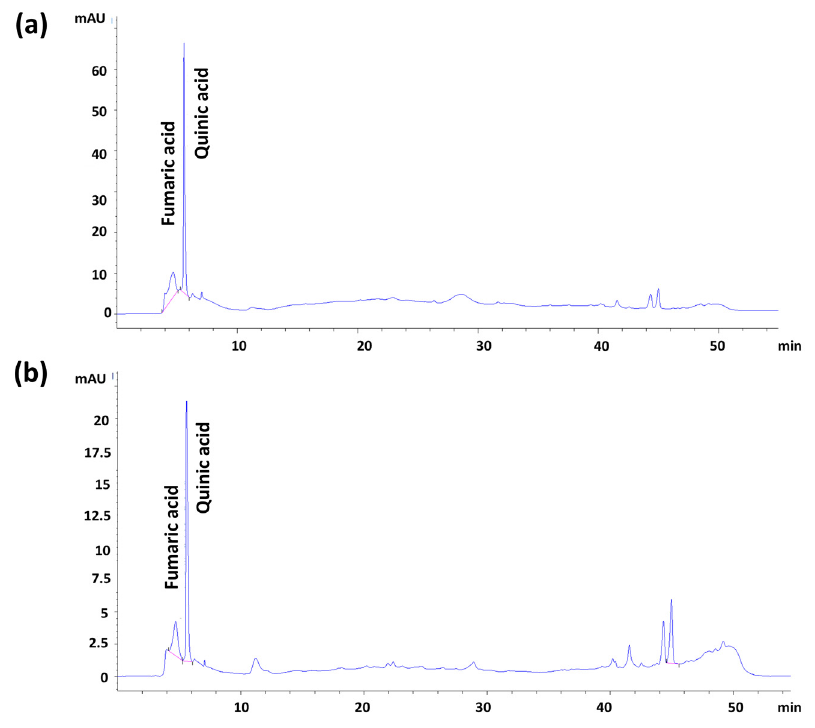
Figure 7. The HPLC-DAD chromatogram of pomegranate peel ( a ) and seed ( b ) extracts. Table 2. Quantitative determination of two phenolic compounds using HPLC-DAD.